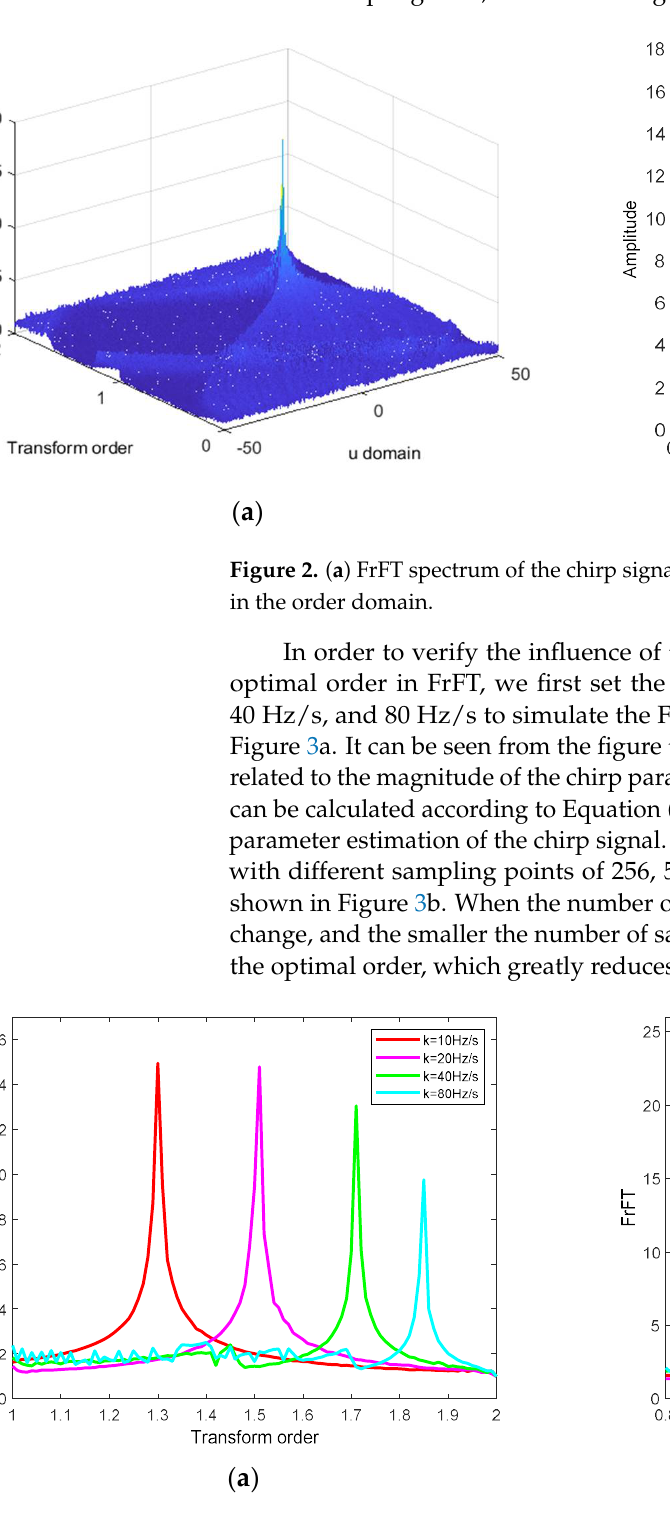
Figure 3. Schematic diagram of the FrFT optimal order of the chirp signal under different ( a ) chirp parameters and ( b ) sampling points.